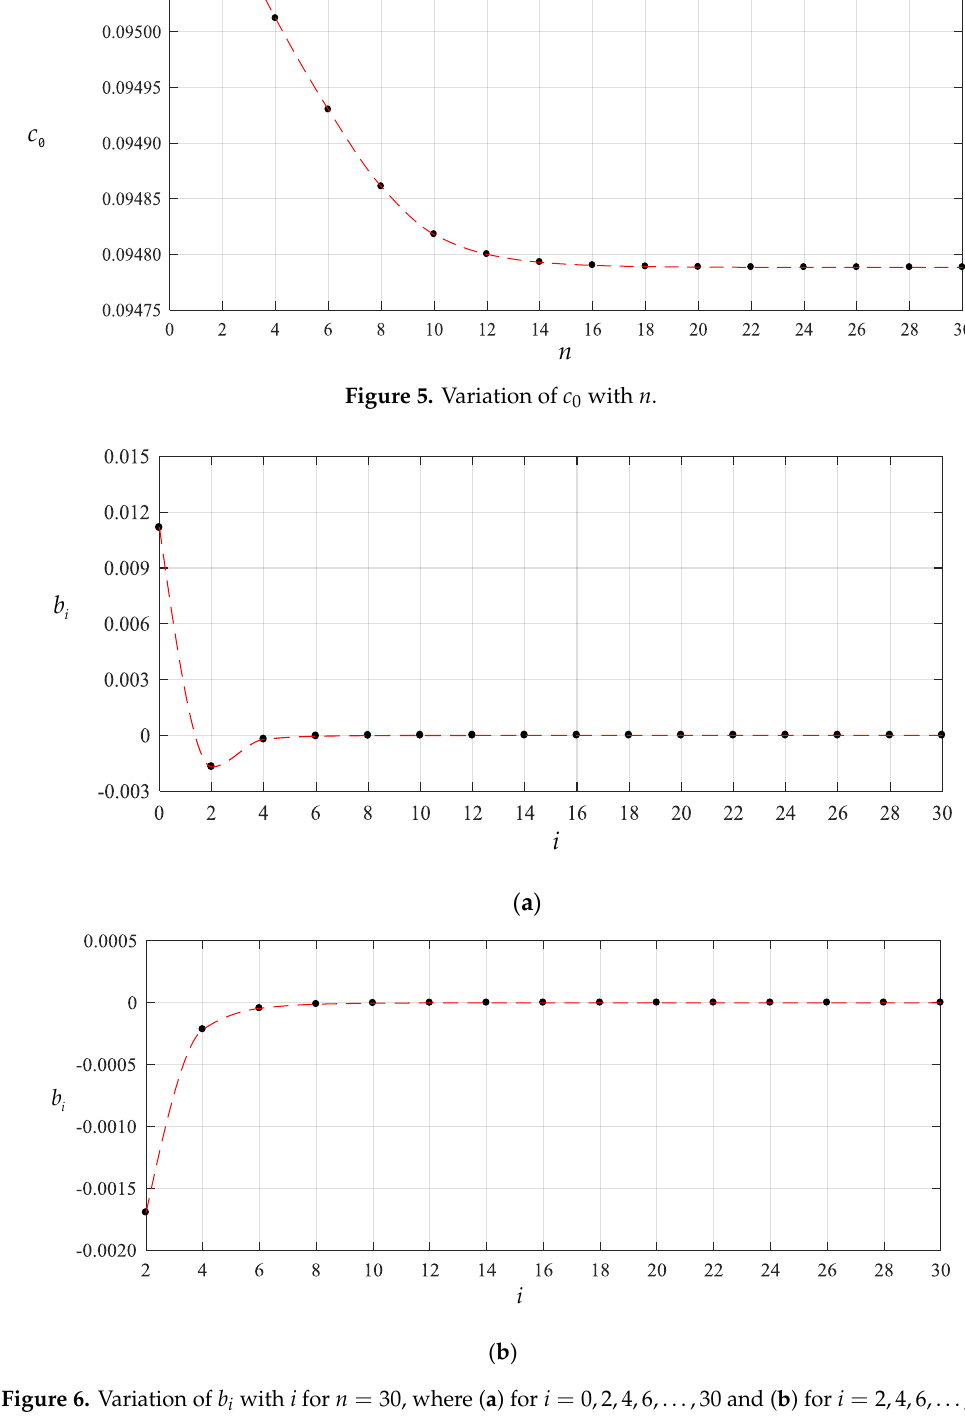
Figure 6. Variation of b i with i for n = 30, where ( a ) for i = 0,2,4,6, ... ,30 and ( b ) for i = 2,4,6, ... Figure 6 . Variation of b with i for 30  n , where ( a ) for  0,2,4,6,...,30 i and ( b ) for  2,4,6,...,30 i . i